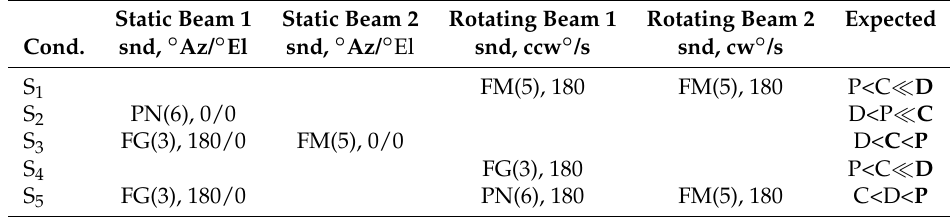
Table 4. Description of the conditions of experiment 3, their sound material (as described in Section 2.1), beam direction/rotation parameters, and their expected ranking of the three